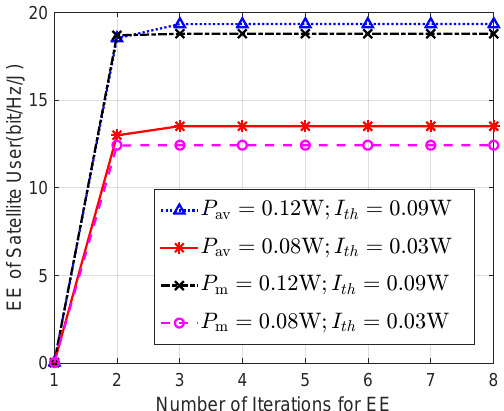
Figure 2. The EEs of the satellite user versus number of the iterations in Algorithm 1 with m I = 1 and Ω = 1. I